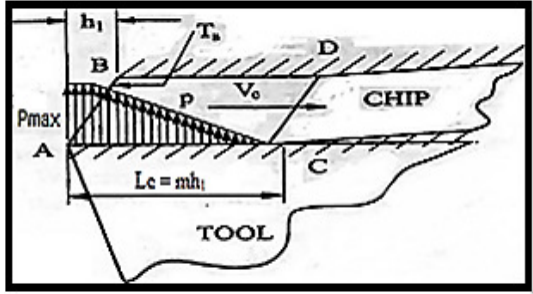
Fig. 3. a. The area of